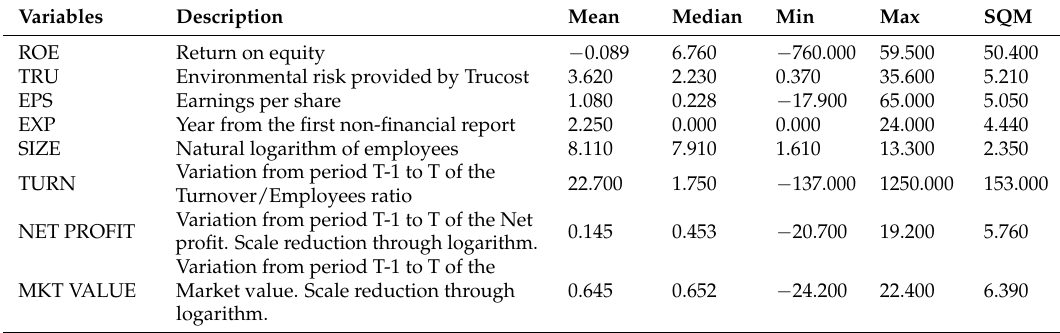
Table 2. Descriptive analysis of the variables.